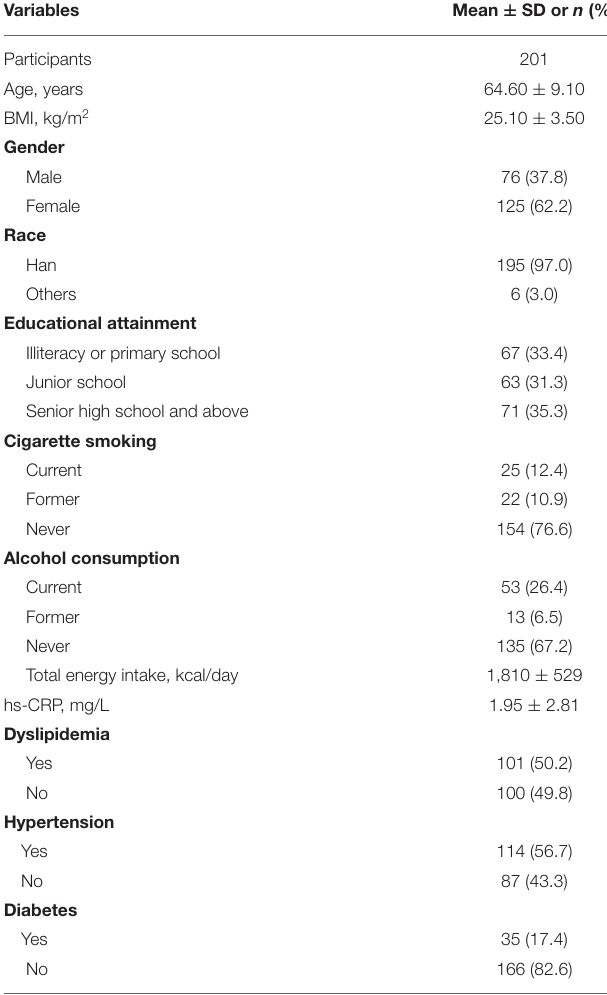
TABLE 1 | Demographic characteristics and health status of participants throughout the study